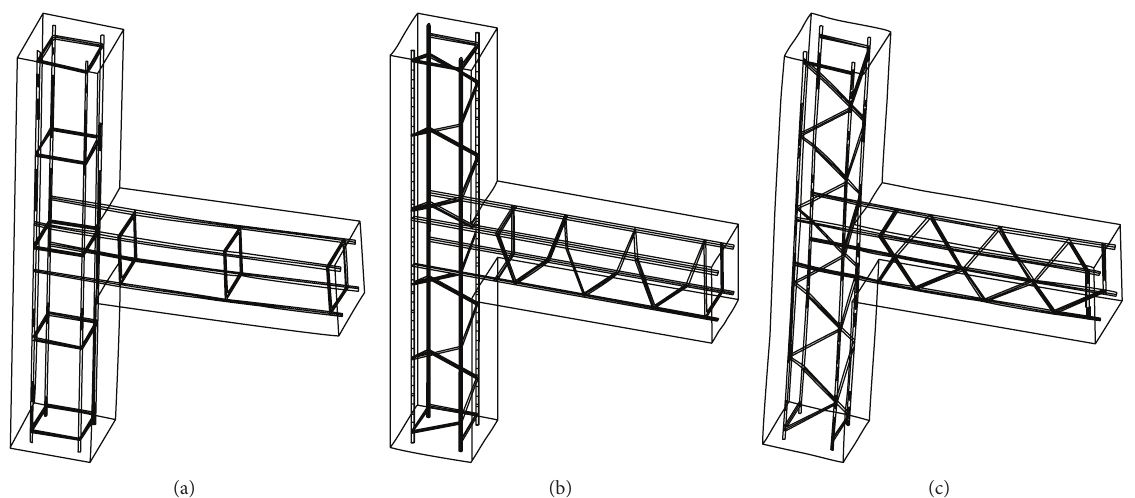
Figure7: Definition ofreinforcement barswith “Link180Element” inANSYS (a) DCL-CONVEN,(b)DCL-SINGLE, and (c)DCL-DOUBLE.